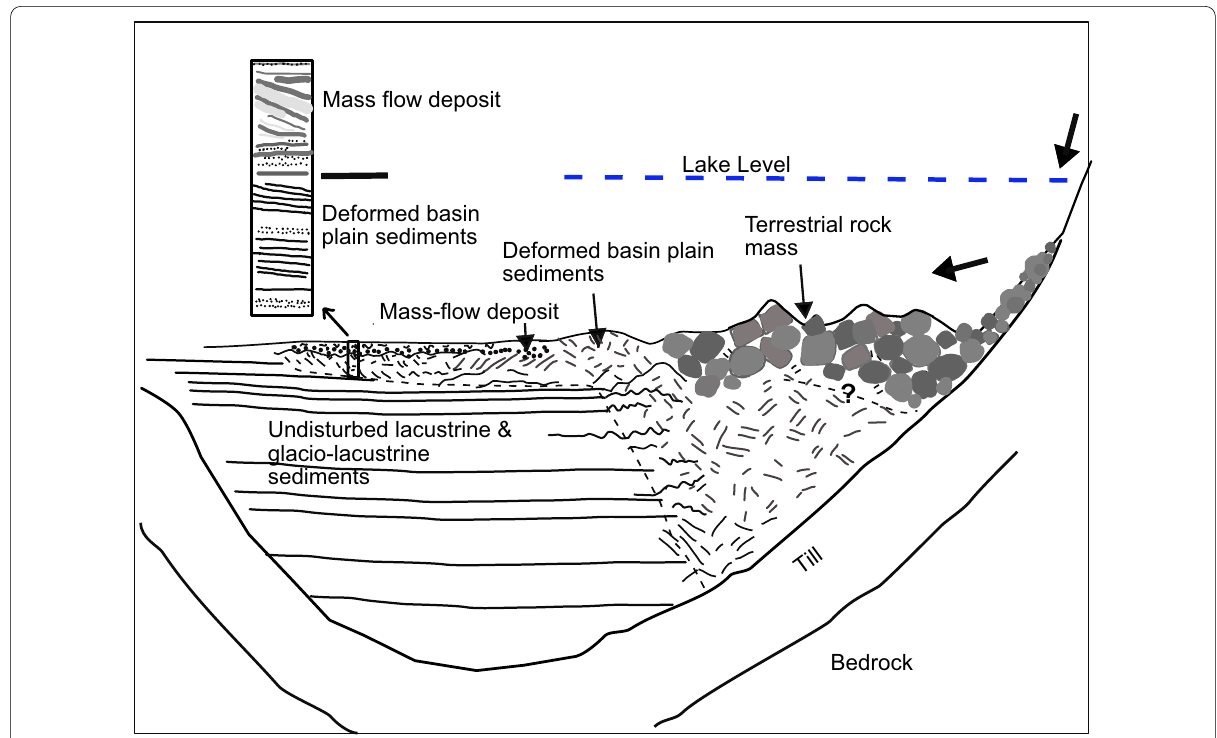
Fig. 8 Schema of the off-shore deposition of the prehistorical terrestrial mass movement and the deformation of the basin plain